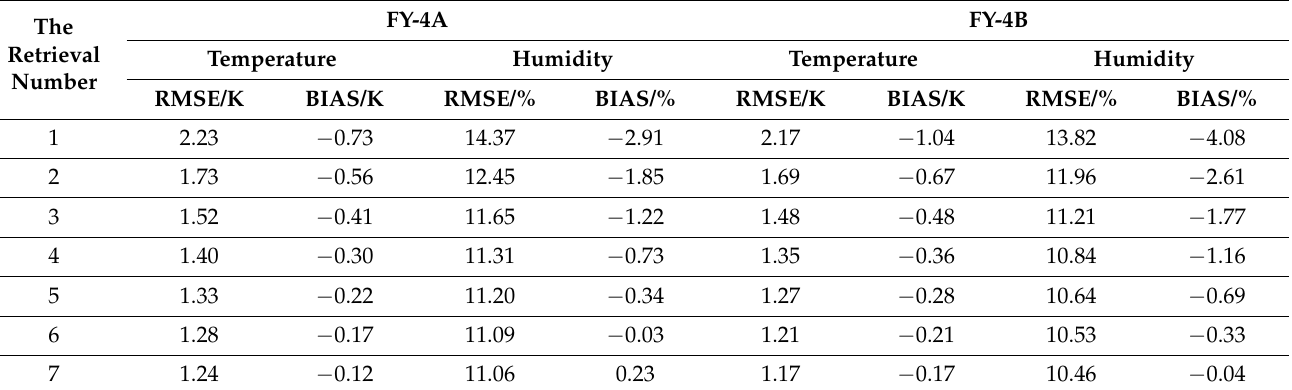
Table 3. The errors of the seven